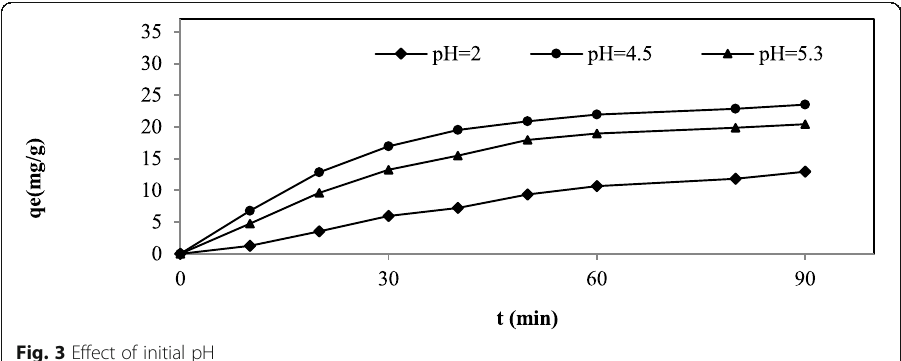
Fig. 3 Effect of initial